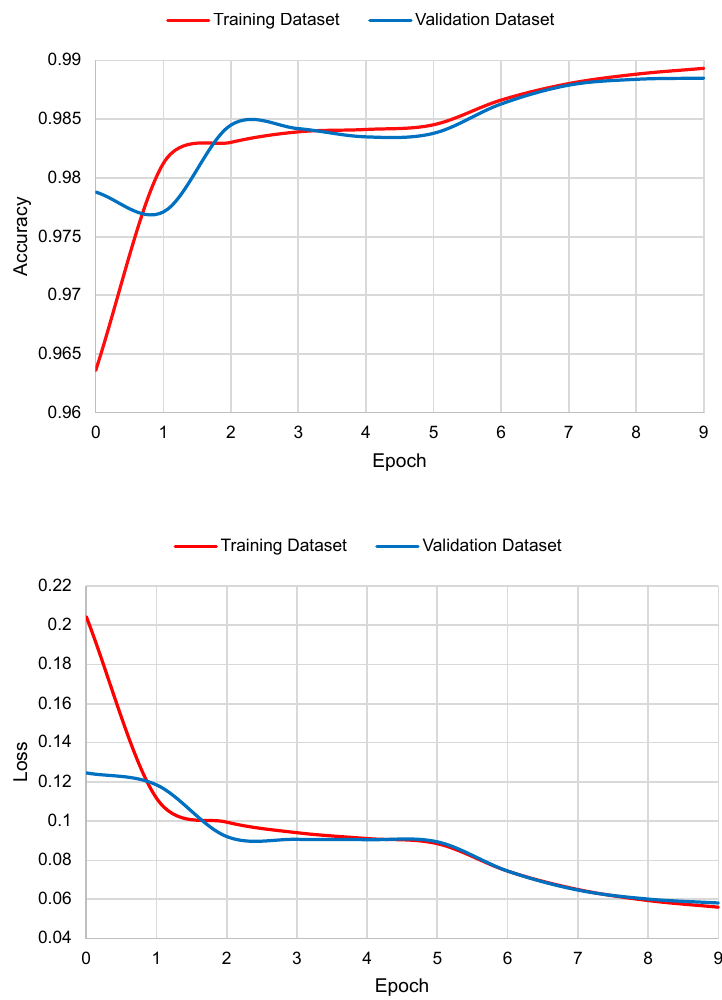
Figure 5. Accuracy and loss graphs for training and validation datasets.